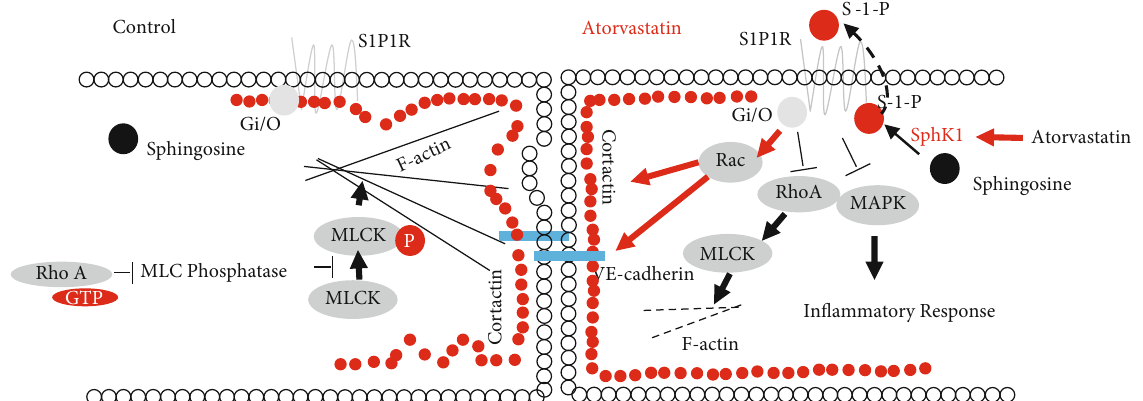
Figure 8: Schematic description of the potential role of SphK1 in atorvastatin-mediated anti-in fl ammatory e ff ect. Under control condition, sphingosine exists as an inactive form and there is balance between the stress fi ber system and the cortactin ring system. When atorvastatin is added, stress fi ber is inactivated, the cortical ring is enhanced, and the VE-cadherin junction is tightened. Meanwhile, atorvastatin inhibits the MAPK signal pathway and attenuates in fl ammatory responses. Sphingosine kinase 1 is a mediator in these